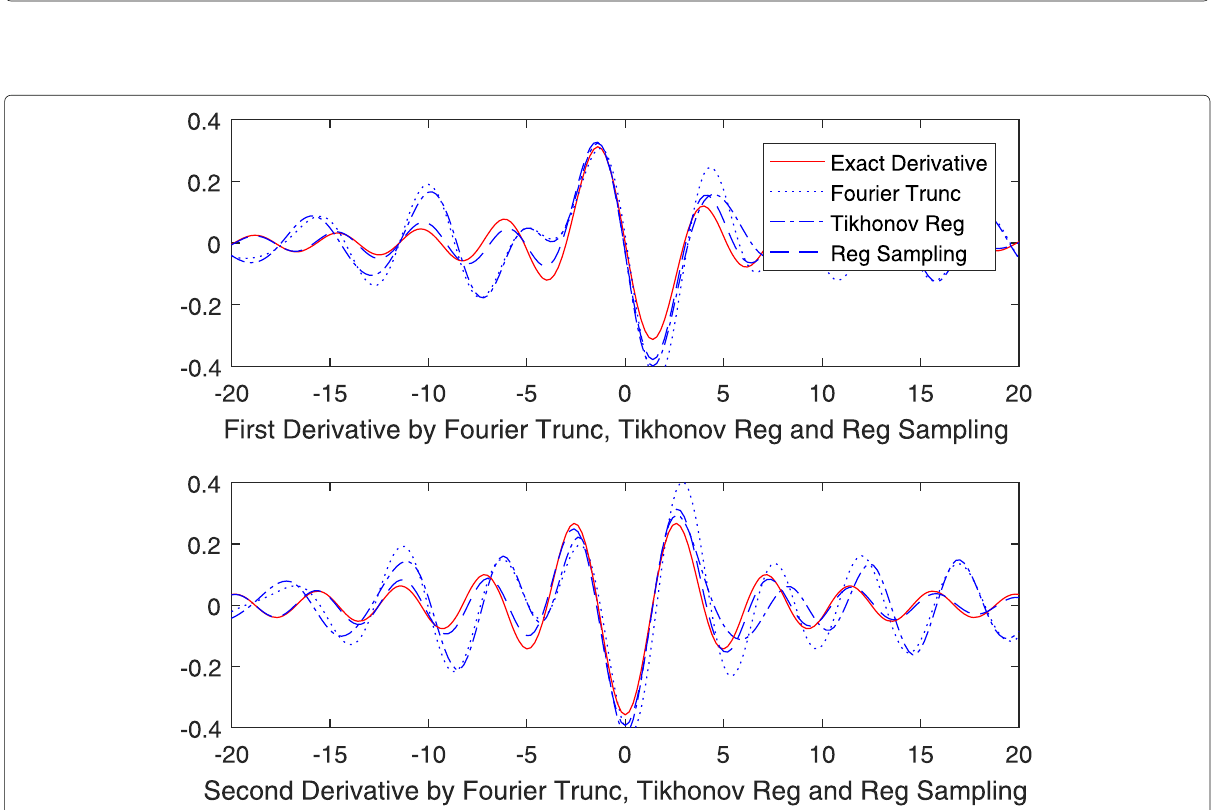
Fig. 2 The simulation results for the uniform noise in Example 2